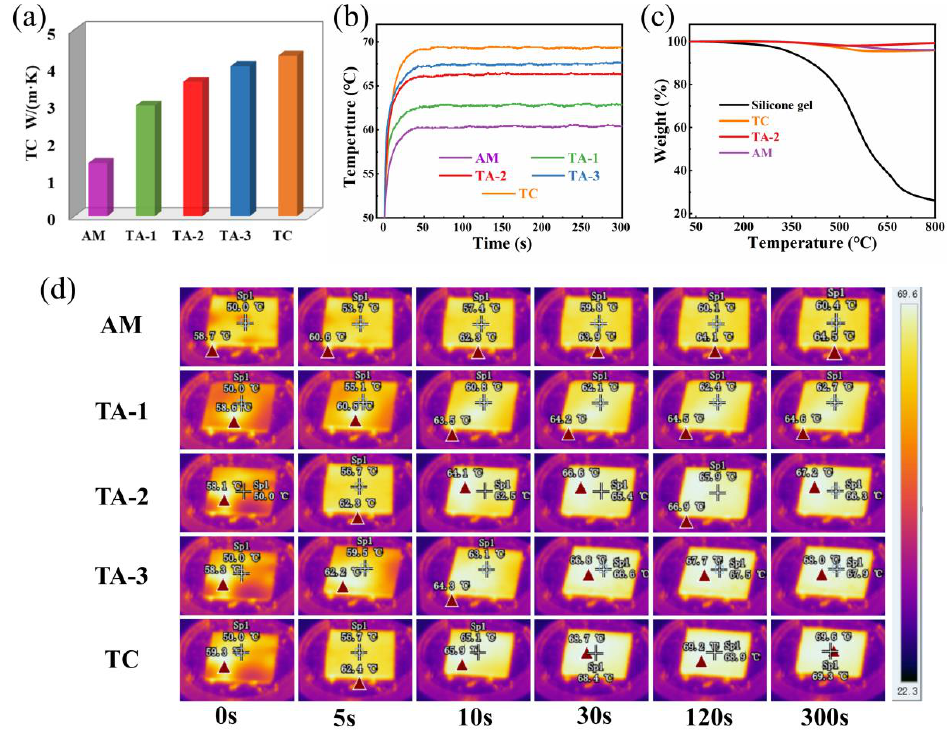
Figure 7. Heat transfer properties of composites: ( a ) thermal conductivity; ( b ) temperature rise curve; ( d ) TGA curve of composites; ( c ) infrared thermal imaging.